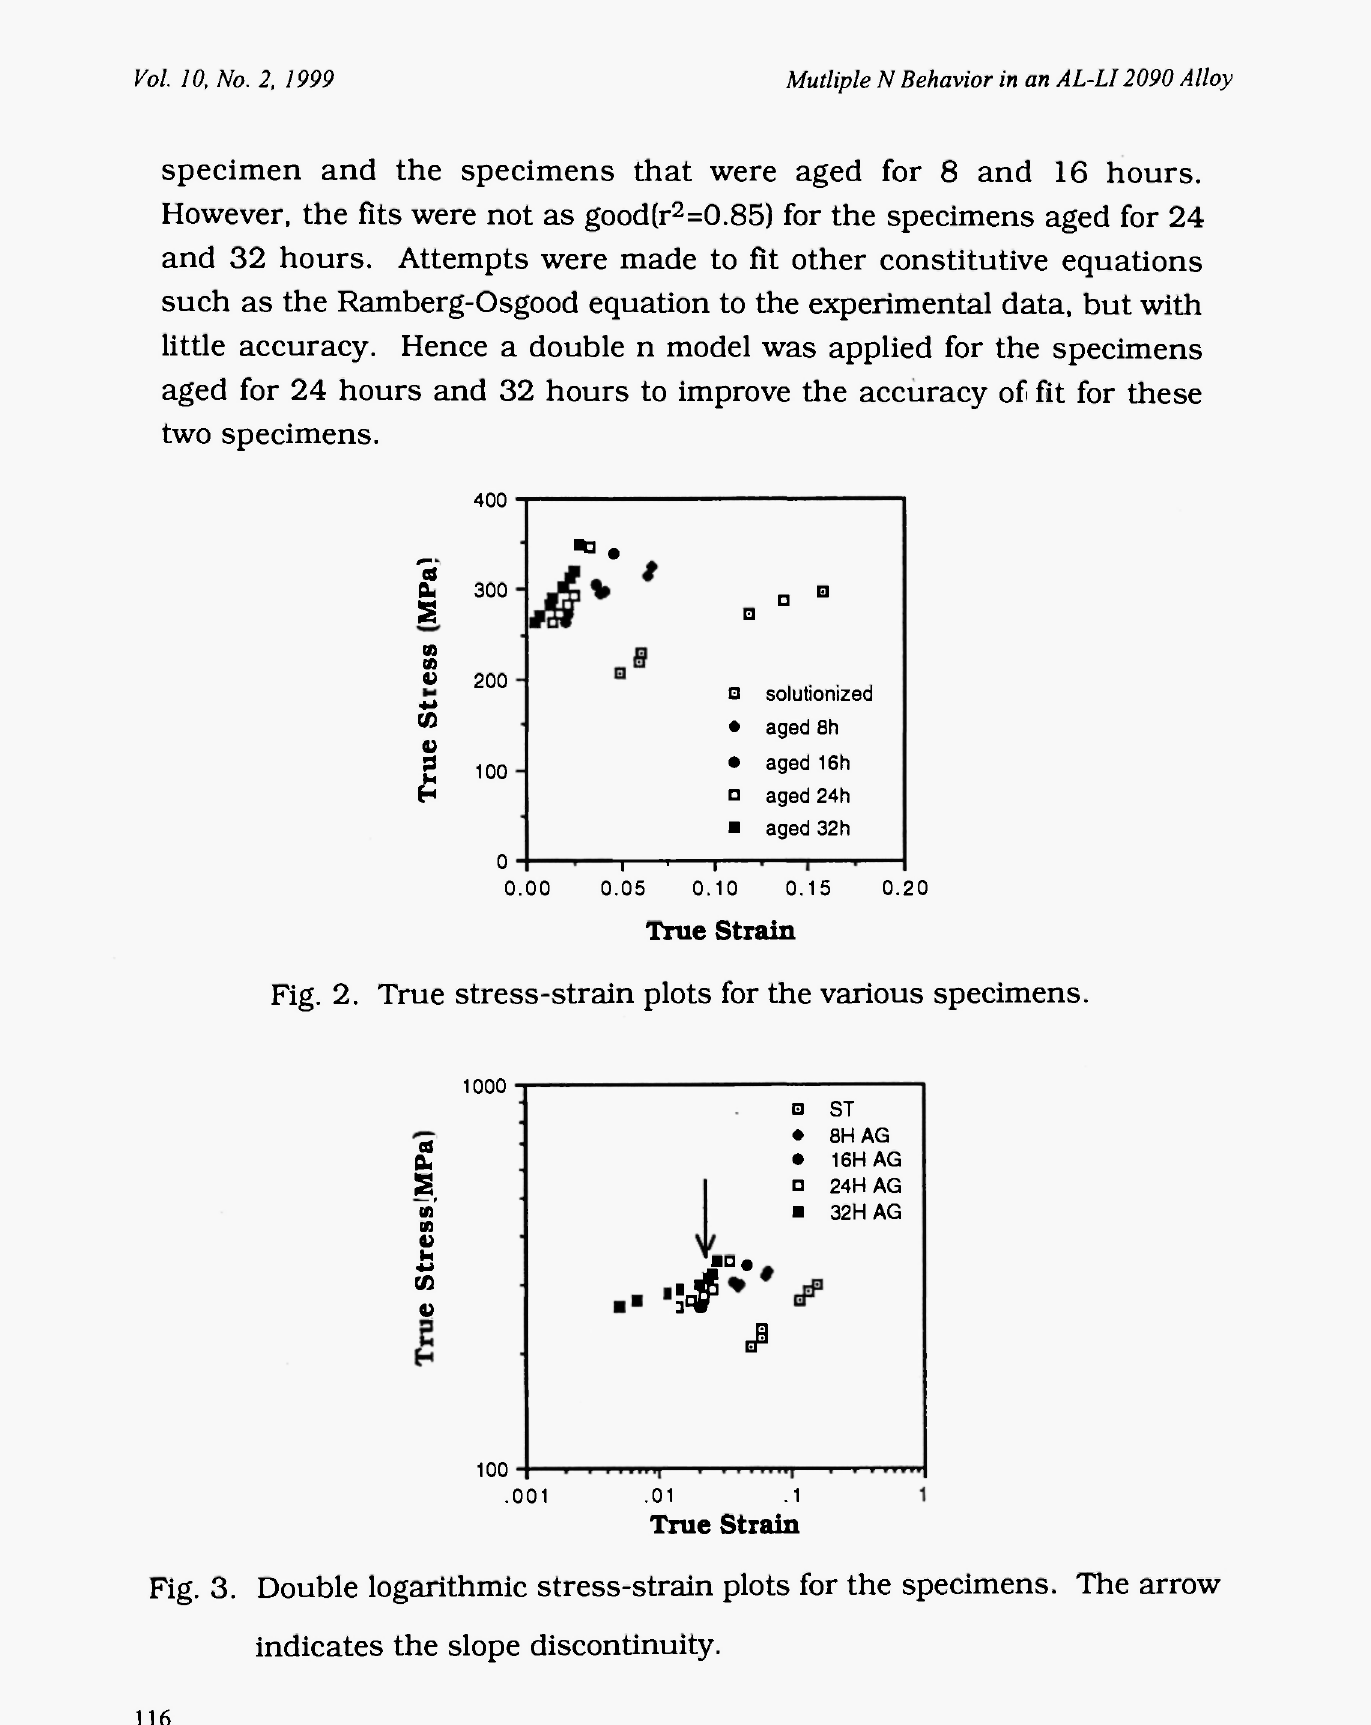
Fig. 3. Double logarithmic stress-strain plots for the specimens. The arrow indicates the slope